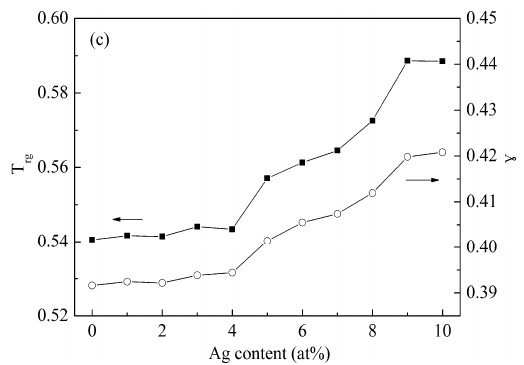
Figure 6. Variations of parameters T g , T x ( a ); ∆ T x ( b ); T rg , and γ ( c ) with the Ag content.